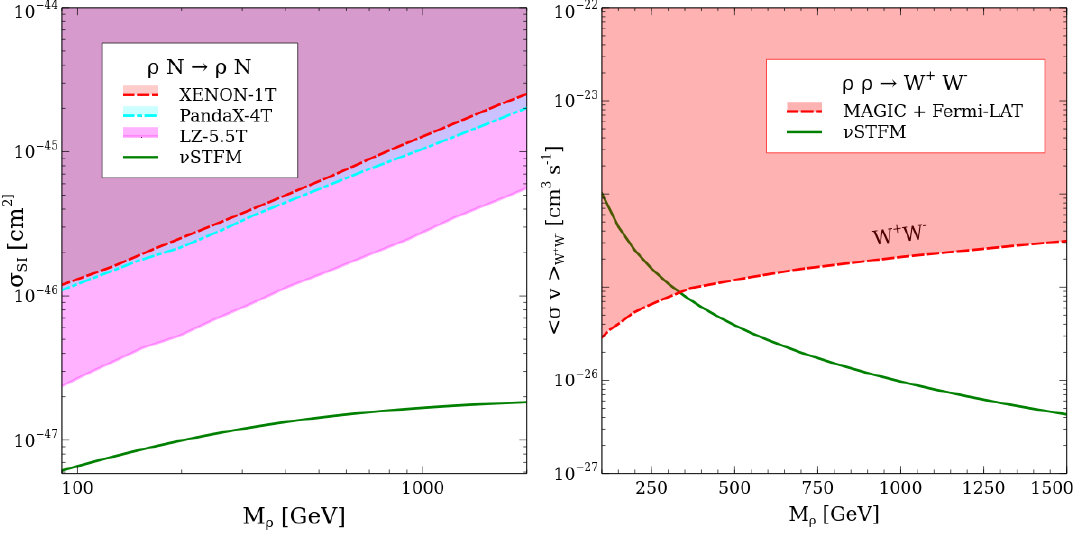
Figure 3 . Bounds on the DM mass from direct detection search at the Xenon-1T, PandaX-4T and LUX-ZEPLIN (LZ) detectors (left panel) [22–24] and indirect detection search in W + W − channel by Fermi-LAT (right panel) [25,